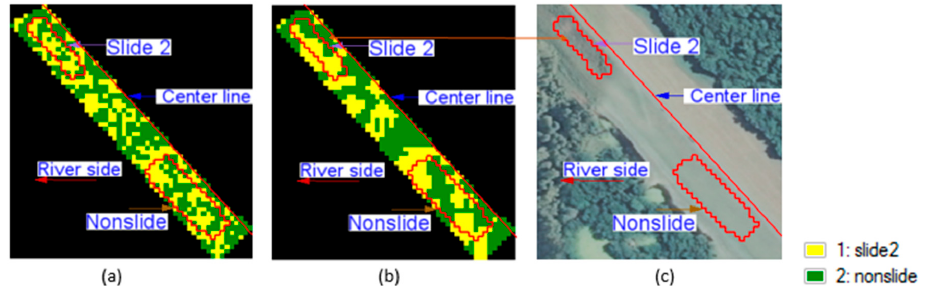
Figure 8. Magnitude data classification for the segment Sample 2: ( a ) without majority filter; ( b ) with majority filter; ( c ) optical image overlaid with slide and nonslide class shapes.